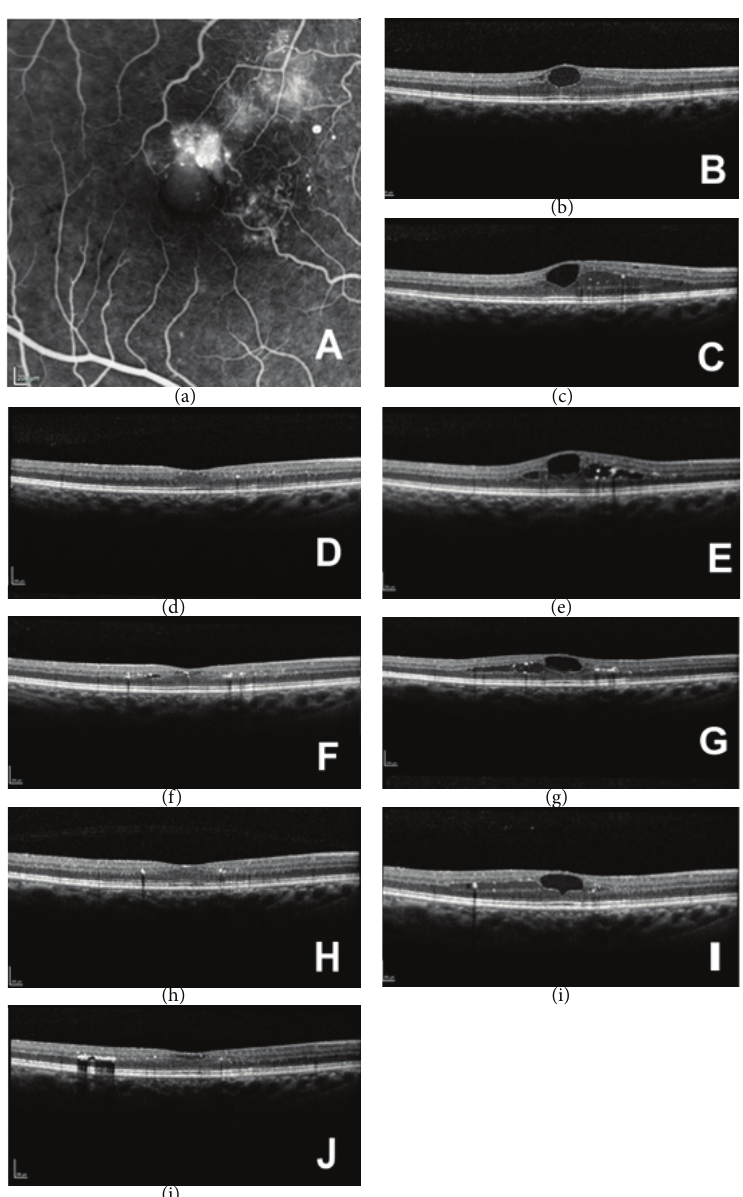
Figure 1: (a) Fundus fluorescein angiography showing perifoveal macular telangiectasia. (b) Ocular coherence tomography (OCT) of the right eye at presentation showing cystoid macular oedema, CMT = 353 𝜇 m. (c) OCT of the right eye on clinic visit following a course of three intravitreal bevacizumab injections (one each consecutive month) showing cystoid macular oedema, CMT = 401 𝜇 m. (d) OCT of the right eye on clinic visit following intravitreal triamcinolone injection showing no cystoid macular oedema, CMT = 282 𝜇 m. (e) OCT of the right eye on second clinic visit following intravitreal triamcinolone injection showing recurrence of cystoid macular oedema, CMT = 397 𝜇 m. (f) OCT of the right eye on clinic visit following intravitreal injection of Ozurdex implant showing reduced cystoid macular oedema, CMT = 286 𝜇 m. (g) OCT of the right eye on second clinic visit following intravitreal injection of Ozurdex implant showing a recurrence of cystoid macular oedema, CMT = 349 𝜇 m. (h) OCT of the right eye on clinic visit following second intravitreal injection of Ozurdex implant showing a reduction in cystoid macular oedema, CMT = 279 𝜇 m. (i) OCT of the right eye on clinic visit at four and a half months following second intravitreal injection of Ozurdex implant showing a recurrence of cystoid macular oedema, CMT = 332 𝜇 m. (j) OCT of the right eye on clinic visit at two weeks following a third intravitreal injection of Ozurdex implant showing reduced cystoid macular oedema, CMT = 279 𝜇